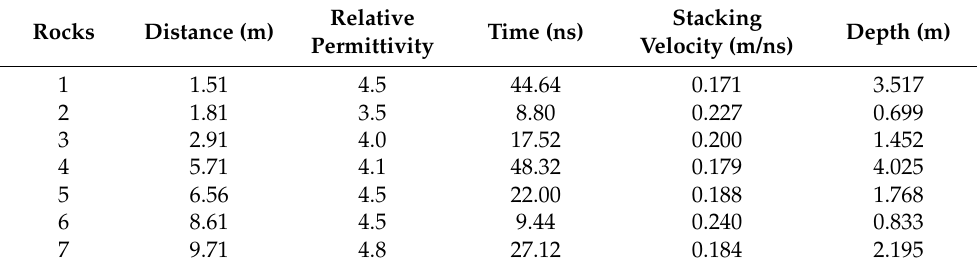
Figure 5. The scanning location of the rocks in the synthetic model. The red-cross indicates the scanning location of the diffractions.